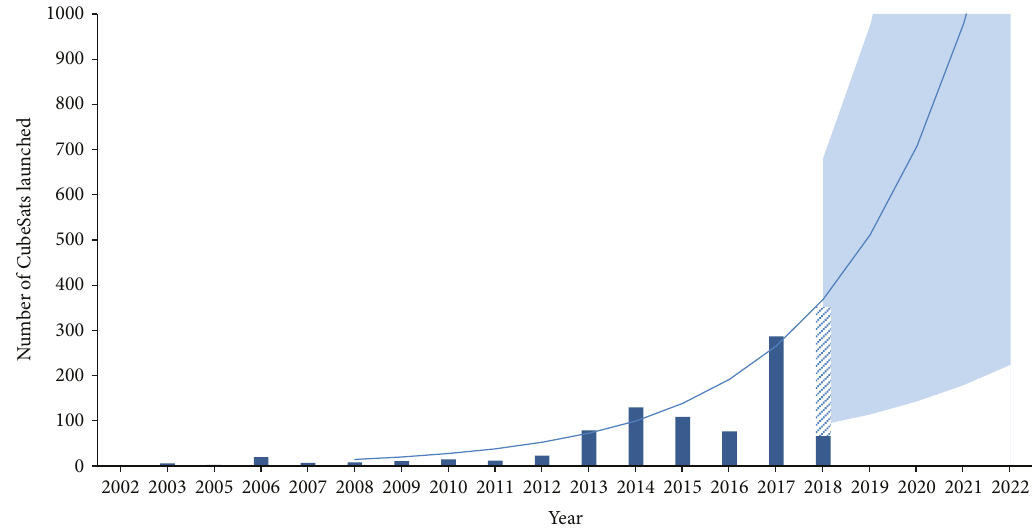
Figure 18: Best fi t for the number of CubeSats launched per year (solid line). The shaded area represents 95% con fi dence interval for future